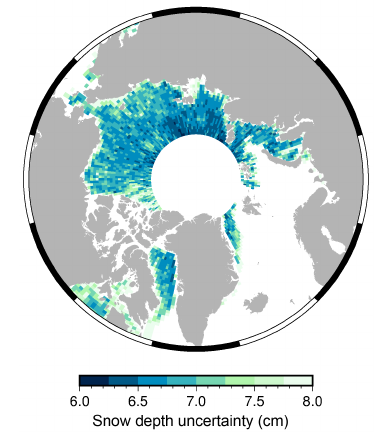
Figure 7. January 2016 snow depth uncertainty. Table 3. Results of OIB and DuST comparison for the years 2013–